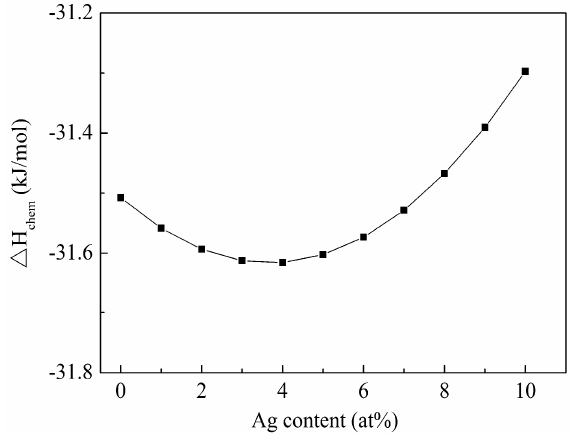
Figure 4. Dependence of chemical mixing enthalpy ( ∆ H chem ) on the Ag content. Table 1. Heat of mixing and atomic radius for alloying elements.